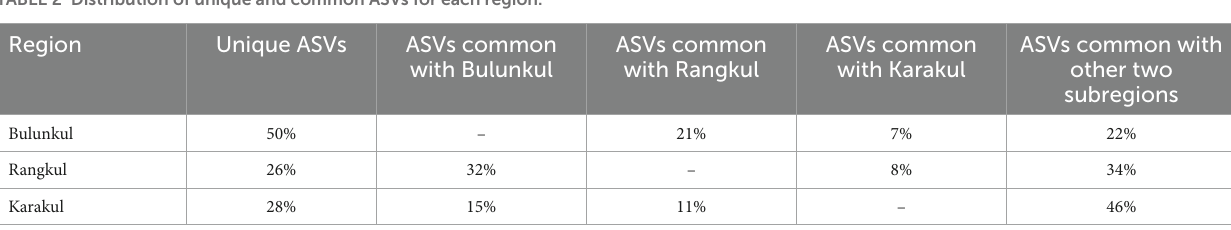
TABLE 2 Distribution of unique and common ASVs for each region. Region Unique ASVs ASVs common